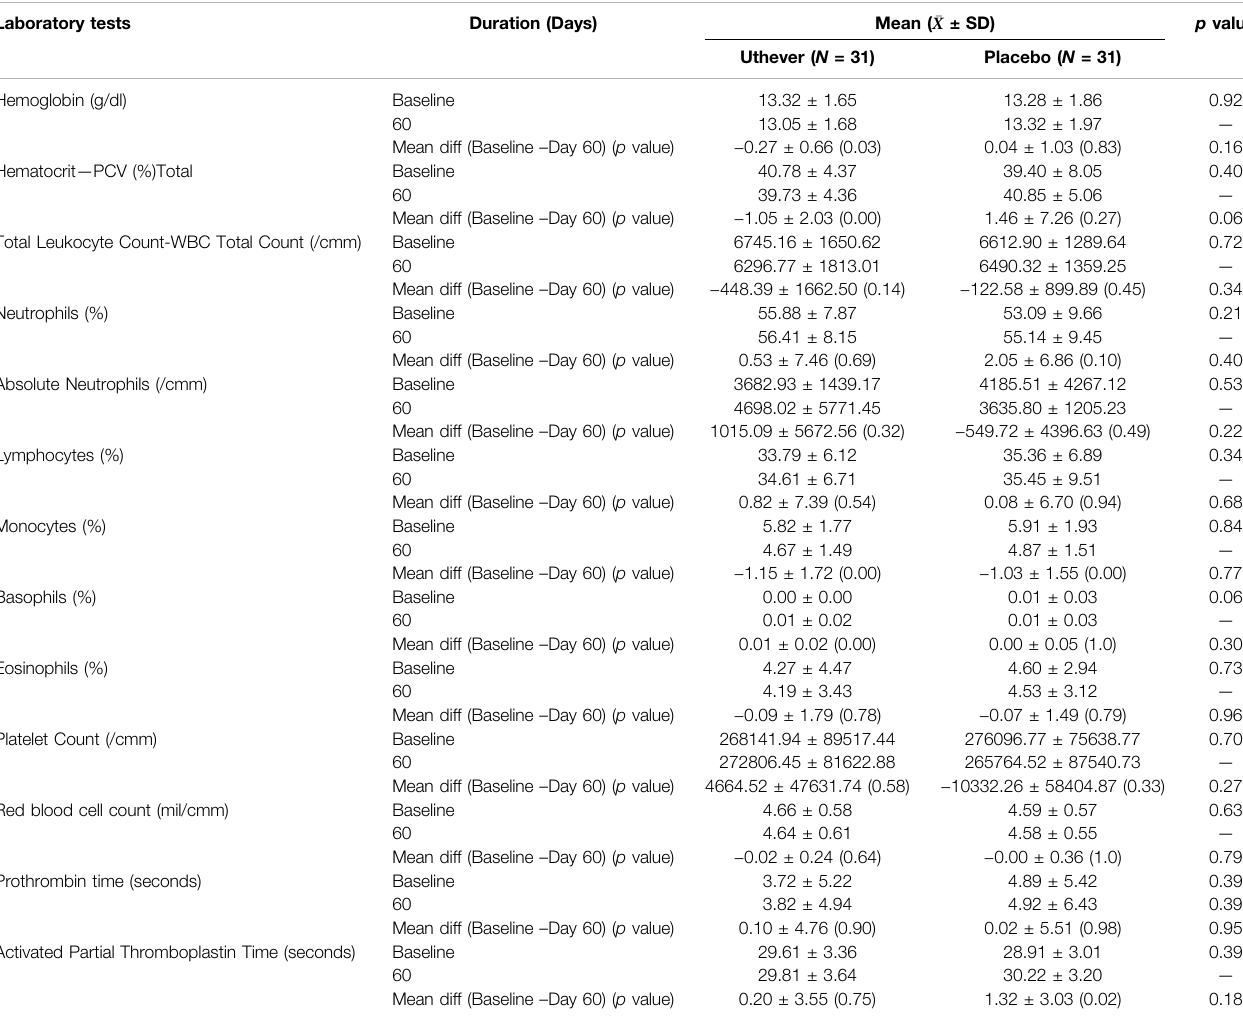
TABLE 10 | Comparison of mean laboratory data (CBC, Hematology) between groups. Laboratory